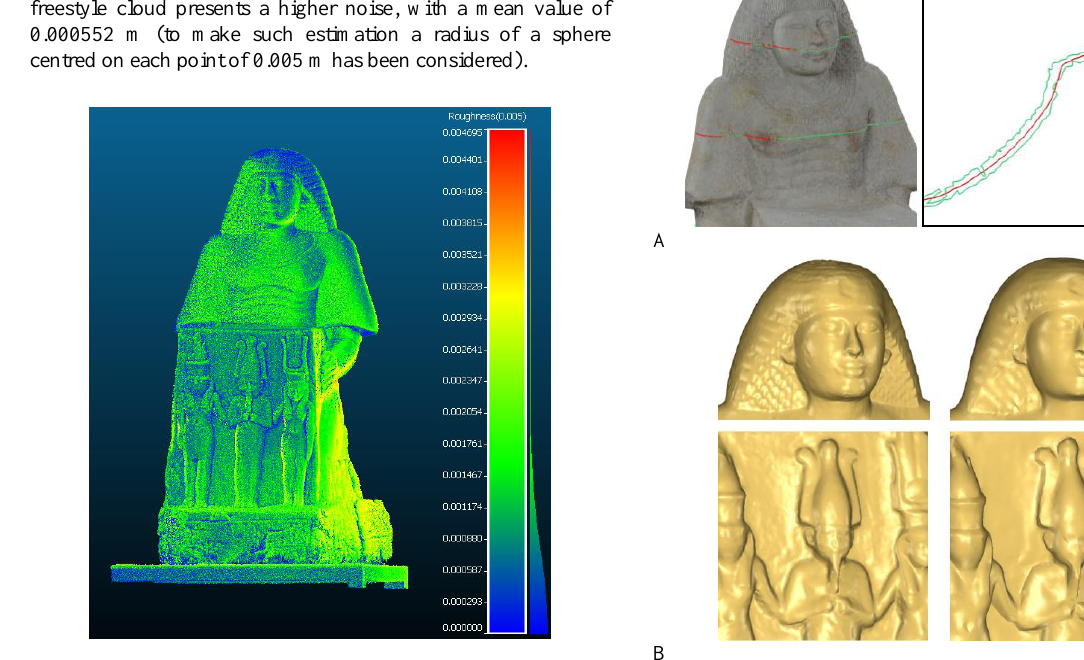
Figure 6. A. In green, section profile pertaining the freestyle cloud (it is possible to notice the data roughness) and the photogrammetric profile in red. B. Visual comparison